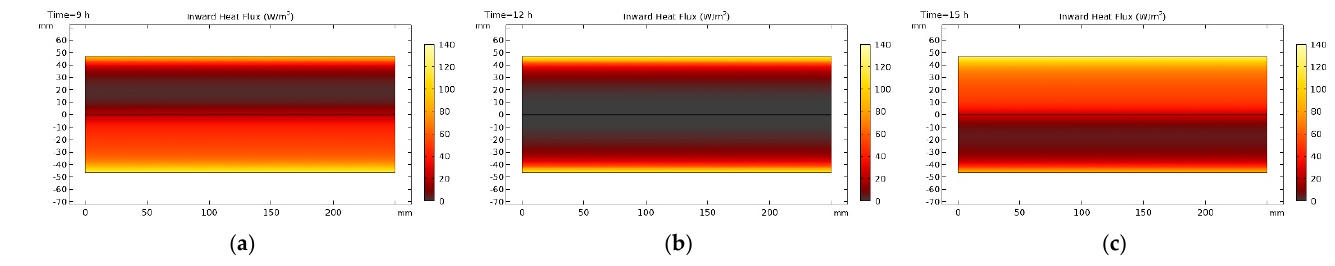
Figure 9. Surface plot of the inward heat flux through the projected area of the lower surface of the triangular SHC without a reflector at ( a ) 9:00; ( b ) 12:00; and ( c ) 15:00 on 1 July 2022.